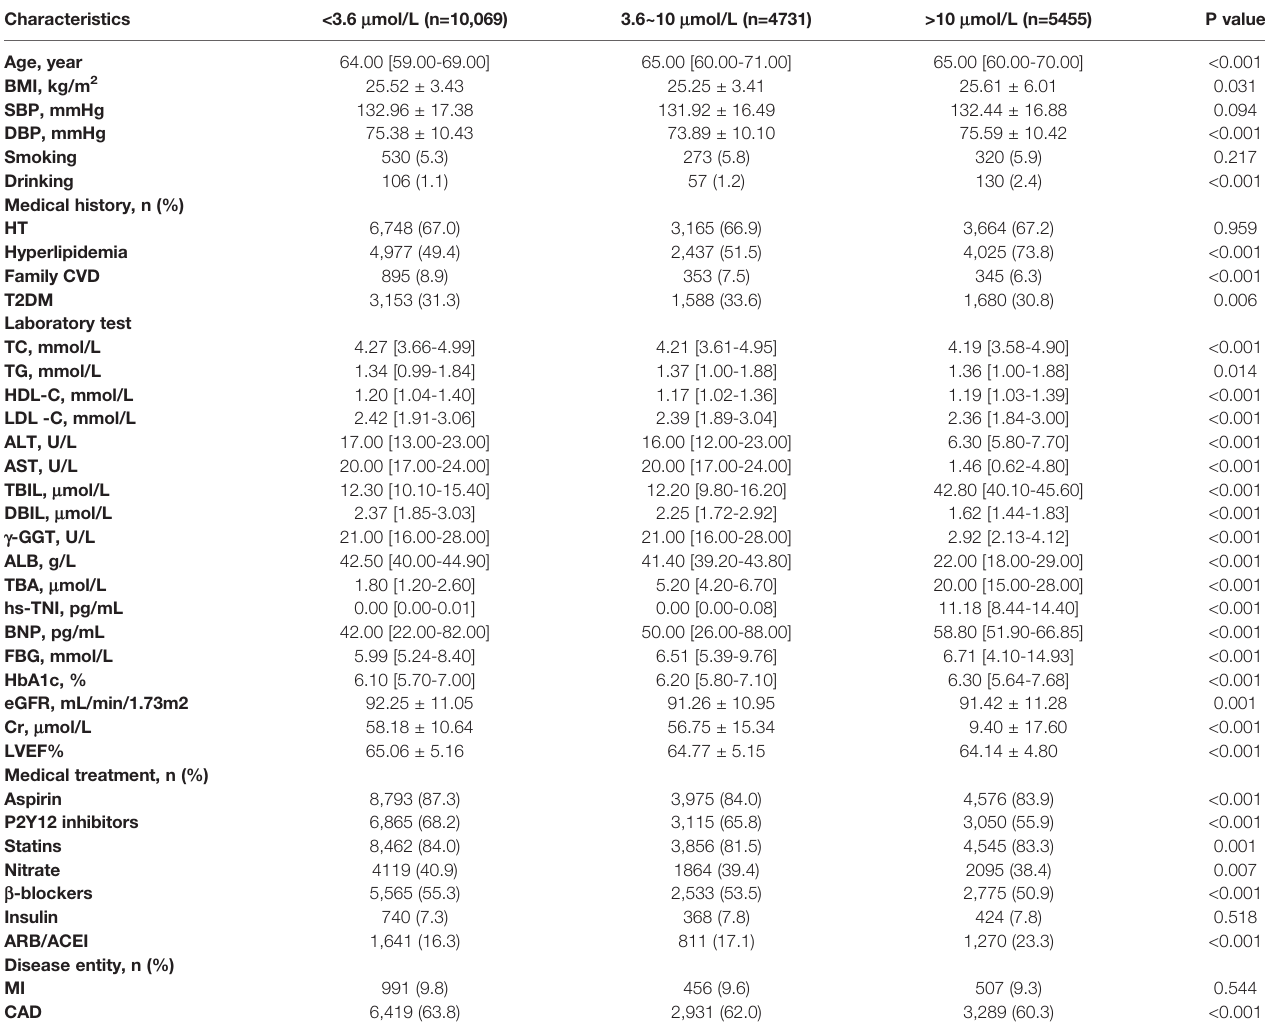
TABLE 3 | Characteristics of patients in different TBA levels.